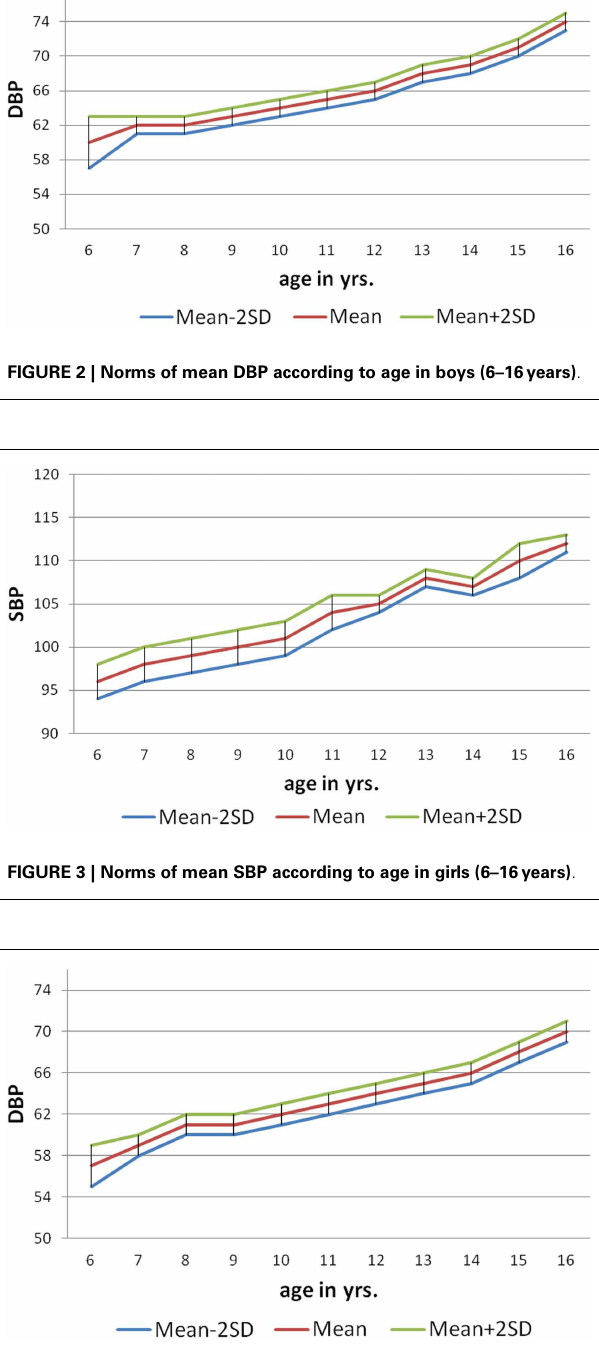
Table 4 | Relation of mean systolic blood pressure and mean diastolic blood pressure to BMI .